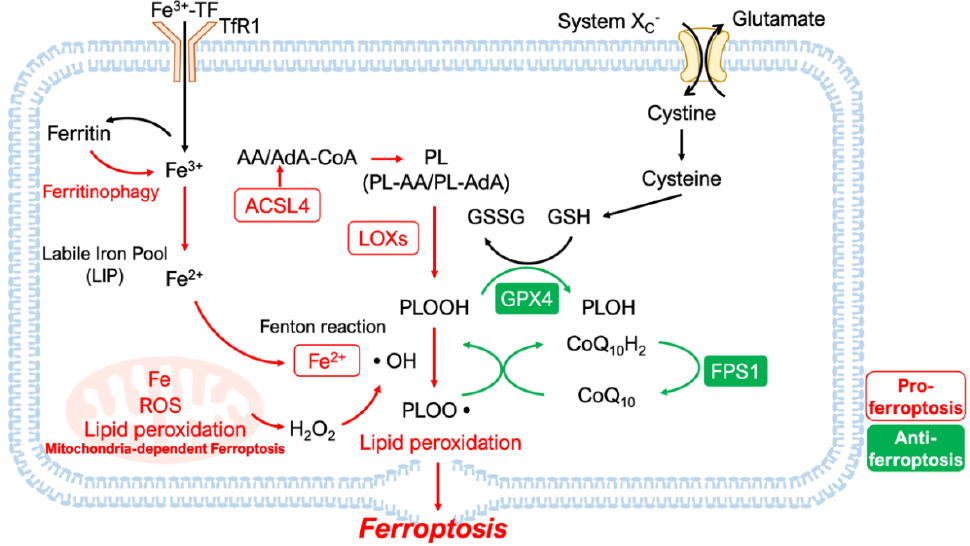
Figure 2. Schematic of the core mechanisms of ferroptosis. Ferroptosis is a form of cell death caused by disrupting the balance between lipid peroxidation (LPO) and its inhibitory mechanisms. In addition to Fe-dependent LPO, the enzymatic formation of phospholipid hydroperoxides (PLOOH) by lipoxygenases (LOXs) also contributes to this mechanism. Incorporating polyunsaturated fatty acids (PUFA) into phospholipids also promotes LPO. Several inhibitory mechanisms against ferroptosis exist, including ferroptosis suppressor protein 1 (FPS1), which reduces phospholipid peroxyl radicals (PLOO • ) by reducing coenzyme Q 10 H 2 (CoQ 10 H 2 ), and glutathione peroxidase 4 (GPX4), a key enzyme which reduces PLOOH and depends on glutathione (GSH) as a substrate. GSH requires cystine for its synthesis, which is imported by system Xc − transporters. DMT1, Divalent Metal Transporter 1; TF, transferrin; ROS, reactive oxygen species; • OH, hydroxyl radical; • PL, phospholipid radical; ACSL4, acyl-CoA synthetase long-chain family number 4; AA, arachidonic acid; AdA, adrenoyl acid.